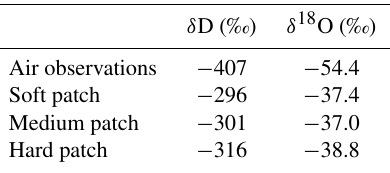
Table 6. Isotopic mean values over the SSDC period. The standard error on the mean value is below 1‰ for δ D and below 0.1‰ for δ 18